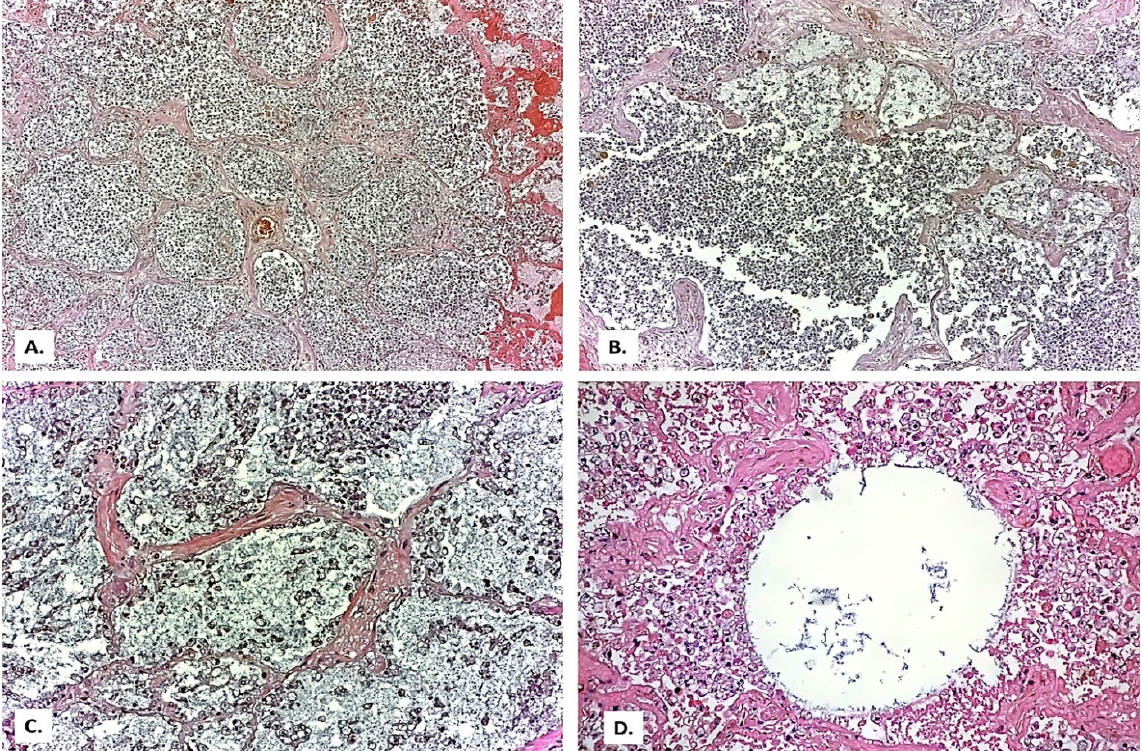
Figure 2. ( A ) General appearance of diffusely thickened alveolar septa (HE × 40). ( B ) Emphysema bubble surrounded by thick fibrous septa (HE × 100). ( C , D ) Thickened septa with myofibroblasts (HE × 200). In all images, the presence of abundant intra alveolar inflammatory exudate can be observed.